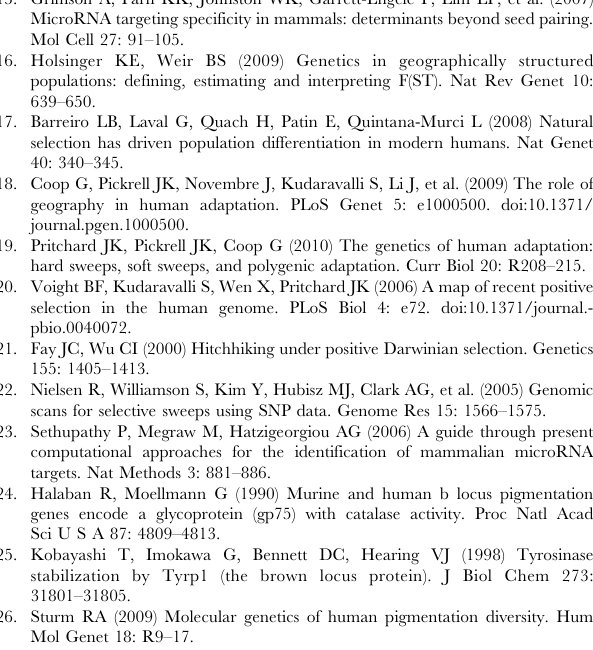
Table S1 The 30 SNPs and 26 human genes identified in this study. The confidence of miRNA target prediction and the Table S2 Summary of molecular functions of the identified genes. Annotations were queried from DAVID (http://david. Table S3 Functional annotation of the 7 genes selected for experimental validation. Table S4 miRNA families considered in this study. miRNAs were grouped into families based on their seed identity. The miRNA family information was deposited in